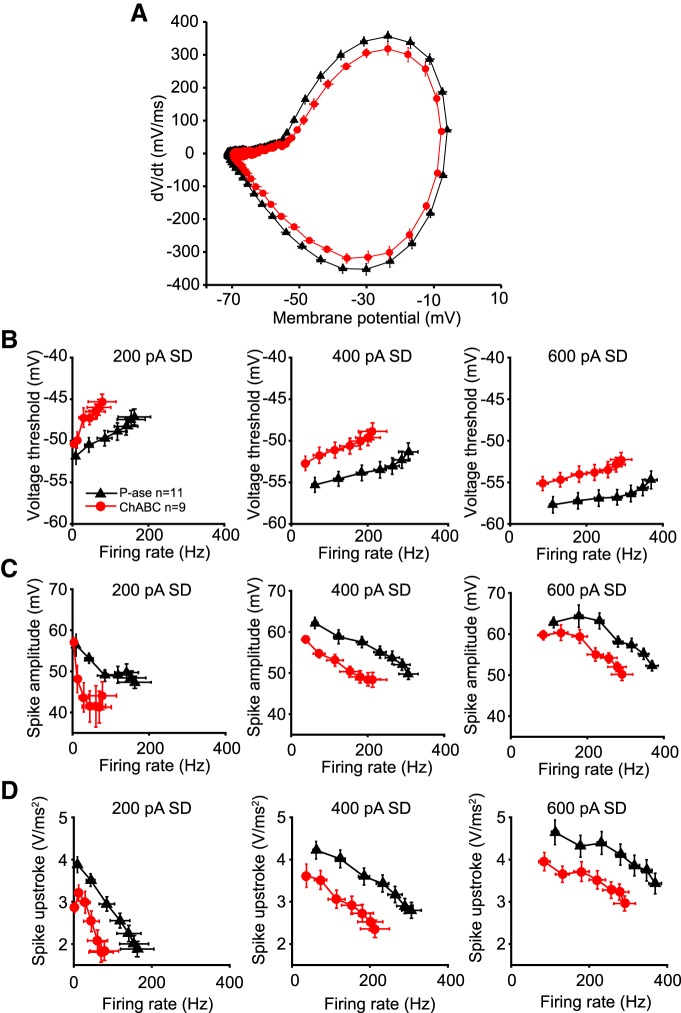
Voltage threshold and spike shape during fast spiking. A, Phase plane plots of white noise evoked spikes during 400 pA SD noise level without a DC step averaged across ChABC-treated (red) and P-ase-treated (black) cells. The membrane potential where the dV/dt begins to increase is more depolarized in ChABC-treated cells, indicating a more depolarized voltage threshold. Also note that the upstroke of the spike is slower (lower peak dV/dt) and reaches a lower membrane potential. B, Voltage thresholds were significantly depolarized in ChABC-treated cells compared with P-ase-treated cells (see Results). Each marker indicates a DC step (from 0 to 600 pA) plotted at the average evoked firing rate and the average voltage threshold during the step. C, Spike amplitude was significantly smaller in ChABC-treated cells. D, The acceleration of the membrane potential was significantly lower in ChABC-treated cells. Error bars are the mean and SEM.